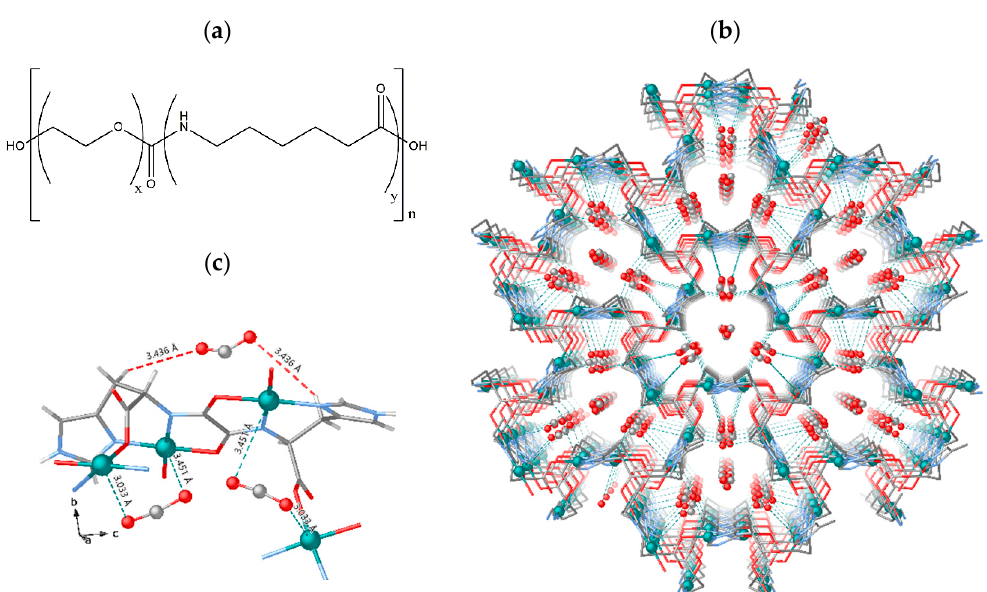
Figure 2. ( a ) Pebax ® 1657 molecular structure and ( b ) perspective views of the porous structures of {Cu 2 [( S,S )-hismox]}·3CO 2 determined by single-crystal X-ray diffraction containing CO 2 [36]. ( c ) Building block of {Cu 2 [( S,S )-hismox]} showing in more detail the coordination of CO 2 .